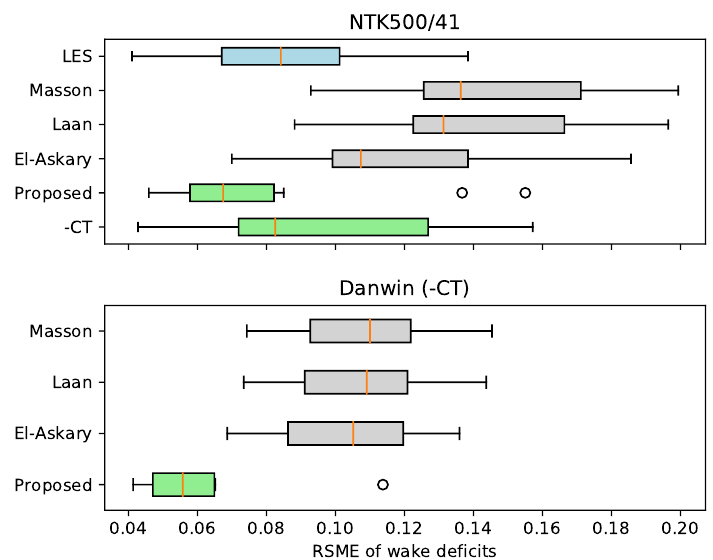
Figure 19. Same as Figure 18 but for boxplots of the root-mean-squared error (RSME) of wake deficits.